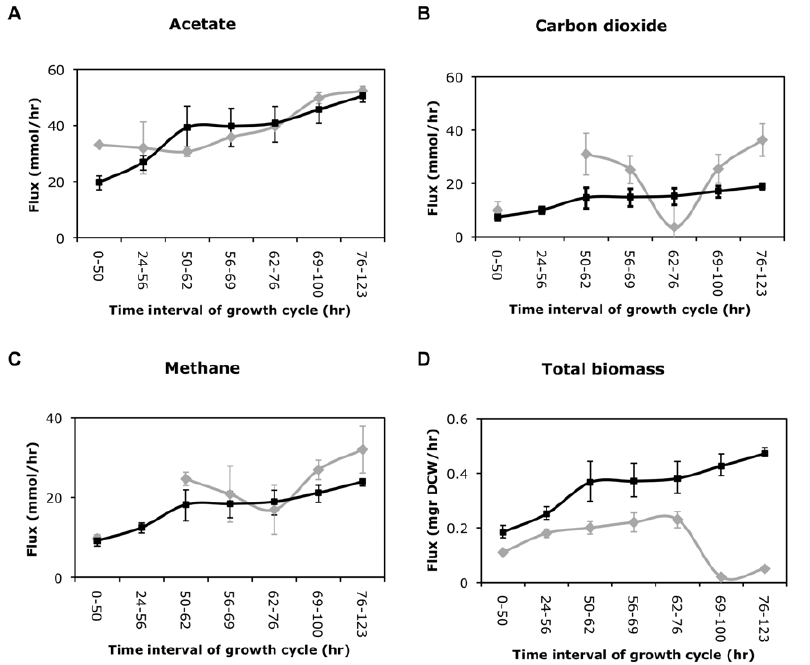
Figure 3. Comparison of the predicted metabolic activities during the syntrophic growth with experimental data. Experimentally determined (gray diamond) and predicted production fluxes by OptCom (black square) for (A) acetate, (B) carbon dioxide (C) methane and (D) total community biomass in the syntrophic growth of D. vulgaris and M. maripaludis . All experimental data were obtained through personal communications with authors of [19]. A separate simulation was performed for each time interval wherein lactate uptake and hydrogen evolution rates were fixed at their experimentally determined values for that interval. Error bars for experimental values indicate the bounds of 95% confidence intervals [19]. The error bars for OptCom predictions were calculated by performing the simulations on the upper and lower bounds of the 95% confidence intervals for measured lactate and hydrogen flux rates.